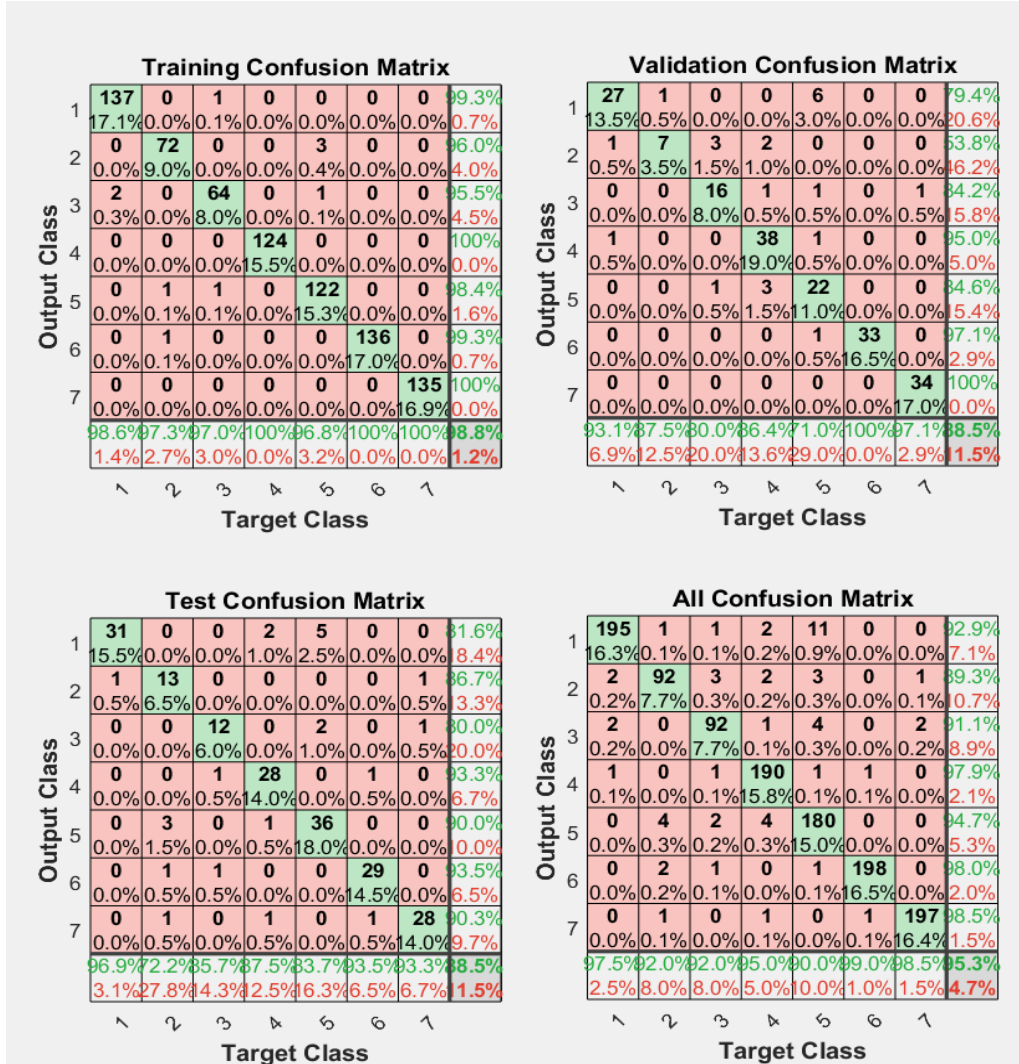
Figure 15. Confusion matrix for the ANN algorithm of the ISIC 2018 dataset.